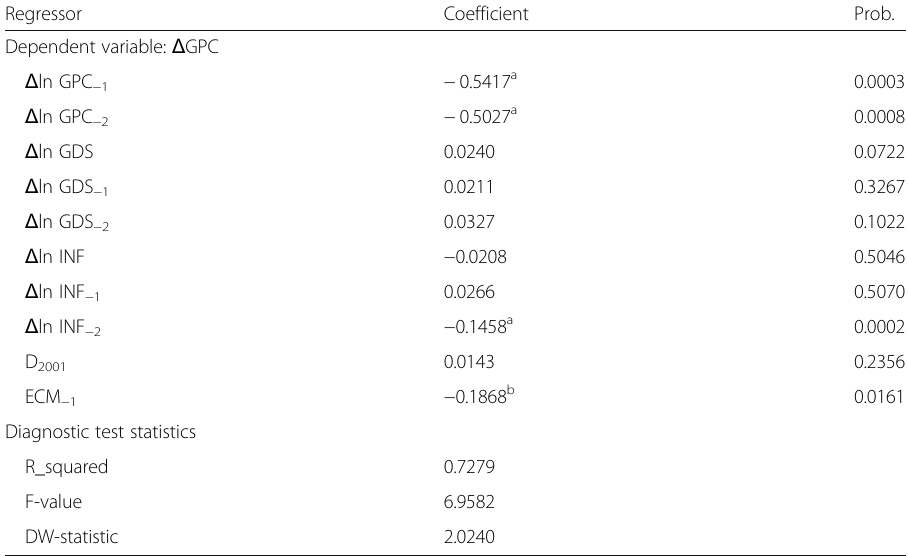
Table 7 ARDL model: ECM